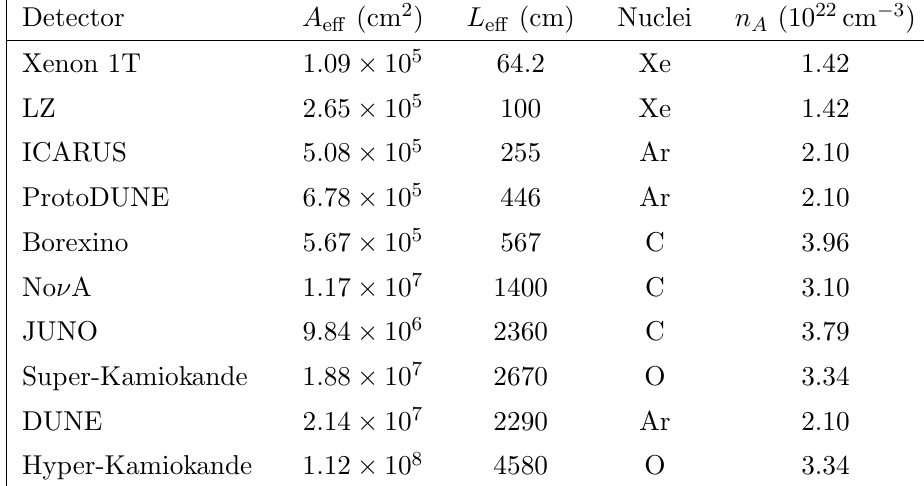
Table 1 . Properties of the detectors considered in our estimation of MDM discovery